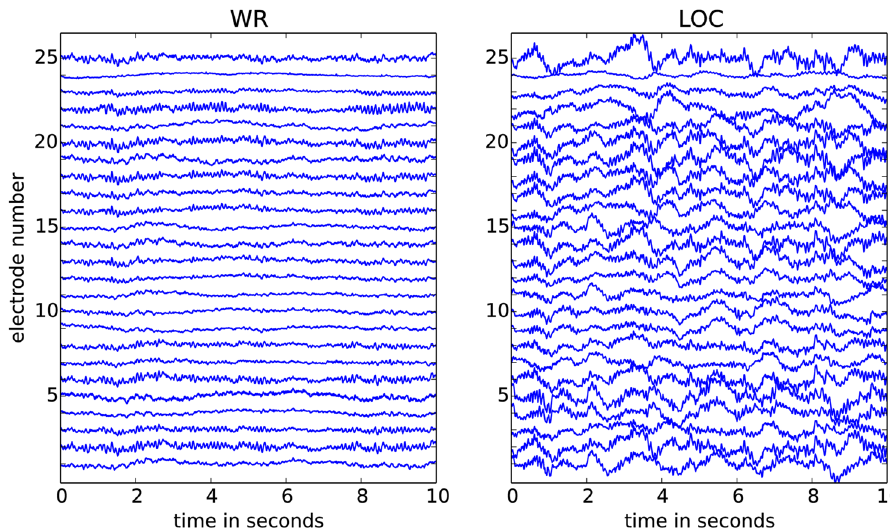
Fig 1. Two 10sec EEG segments from 25 channels. The segment in the left panel is during wakeful rest (WR) and the segment in the right panel is during propofol-induced loss of consciousness (LOC); both segments are shown after pre-processing. The voltage scale is the same for both conditions and the maximal fluctuation shown is approximately 0.1 mV (for more data details, see [16, 38]). The recordings for LOC display visibly stronger slow waves (low-frequency components) as compared to those for WR.